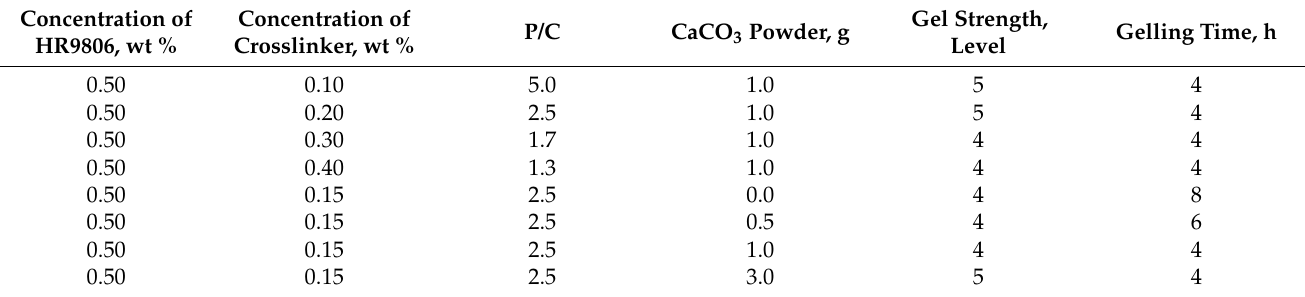
Table 2. Effect of CaCO 3 on gelling effect.